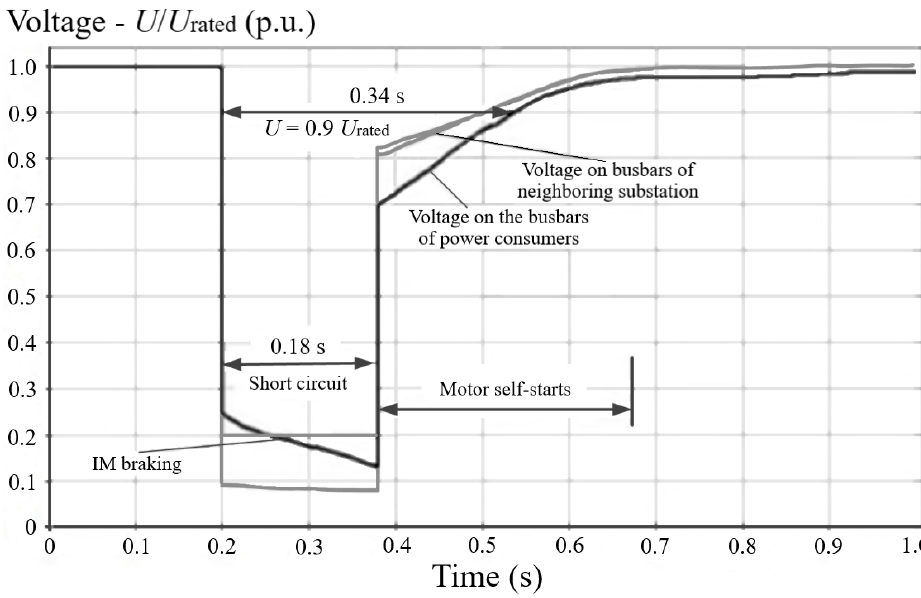
Figure 1. A transient in the EPDN of an industrial enterprise during a near-to-generator three-phase short circuit in the external distribution network.